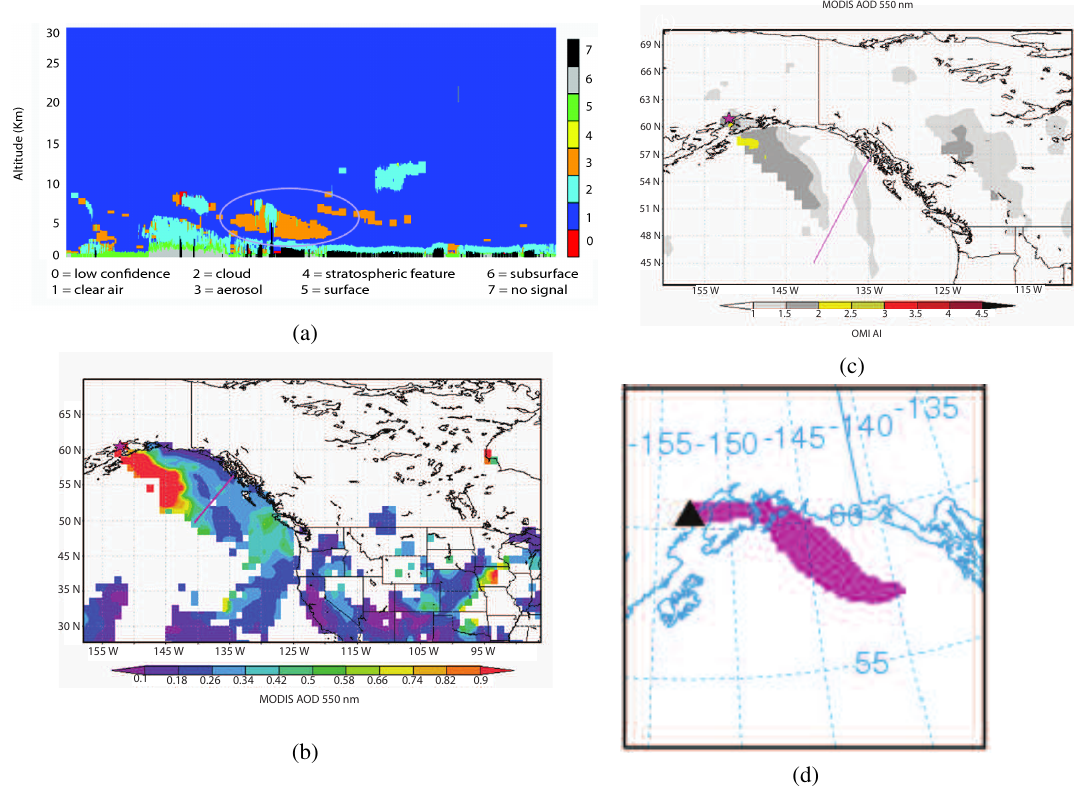
Fig. 4. (a) Vertical feature mask from CALIPSO between 11:31UTC and 11:45 UTC on 2 April. The plume of interest is circled. (b) MODIS AOD(550nm) daily mean for 2 April. Mt. Redoubt is marked with a star. CALIPSO path is shown with a line. (c) Same as (b) , Fig. 4: (a)Vertical feature mask from CALIPSO between 11:31 UTC and 11:45 UTC on April 2. The plume of interest is except for OMI AI. (d) Transport of ash plume (shown in pink) from the 2 April eruption as predicted by the HYSPLIT model. Eruption circled. (b) MODIS AOD(550 nm) daily mean for April 2. Mt. Redoubt is marked with a star. CALIPSO path is shown with a duration of 12 hours and an ash column height of 4.6km were line. (c) Same as (b), except for OMI AI.(d)Transport of ash plume (shown in pink) from the April 2 eruption as predicted by the HYSPLIT model. Eruption duration of 12 hours and an ash column height of 4.6 km were used.